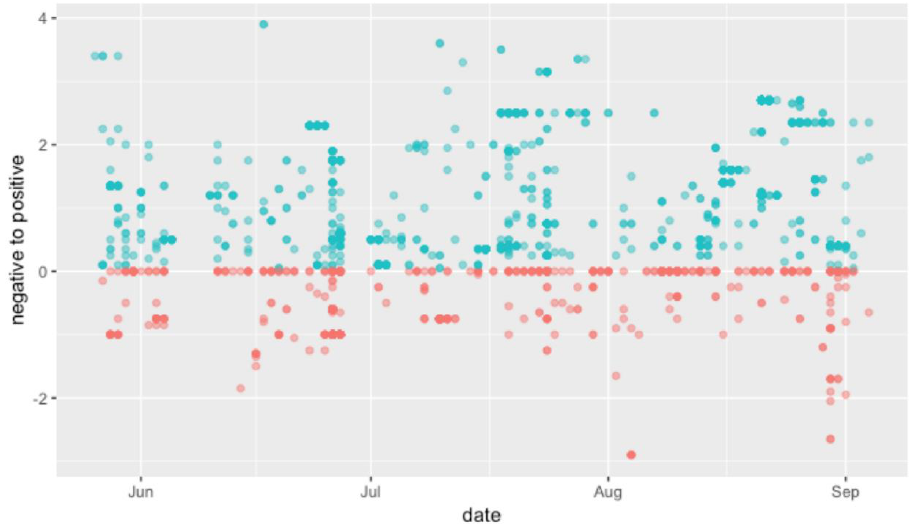
Figure 3. The result of the sentiment analysis (from negative sentiment (red, less than 0) to positive sentiment (blue, higher than 0)).